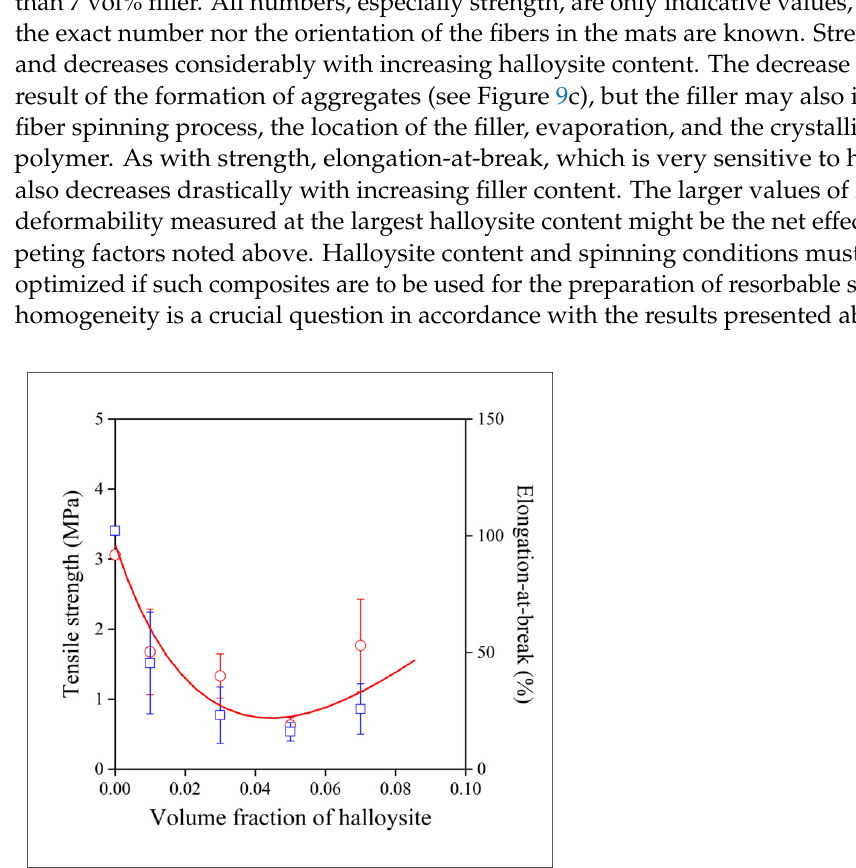
Figure 10. The composition dependence of fiber diameter of electrospun fibers.